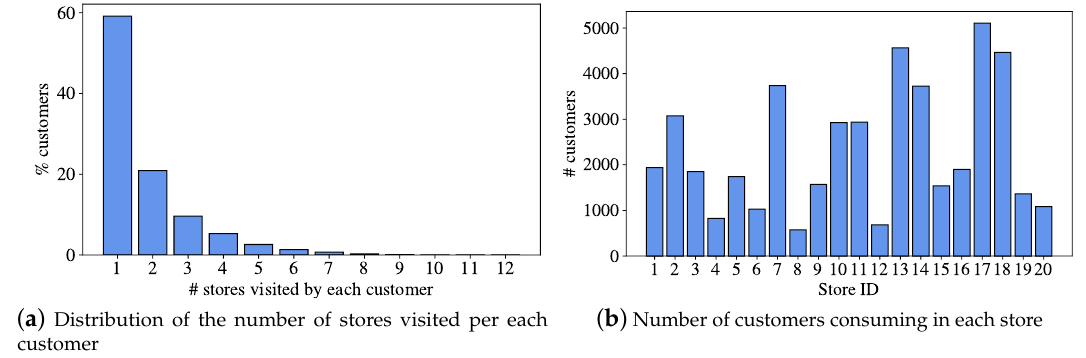
Figure 3. Distribution of customers in the network. Table 1. Distribution (%) of the customers into the different categories.